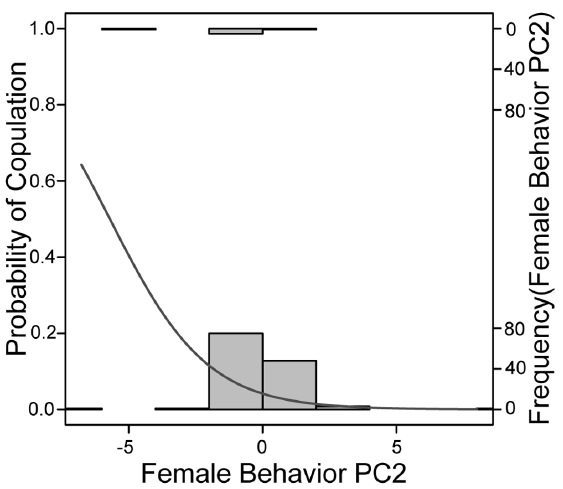
Figure 4. Logistic regression of copulation probability (0=no, 1=yes, left y-axis) vs. female behavior PC2 score (x-axis). The dark grey line shows the fitted logistic regression equation, while the histograms show how many male-female interactions fell into each bin of PC2 scores (right y-axis).